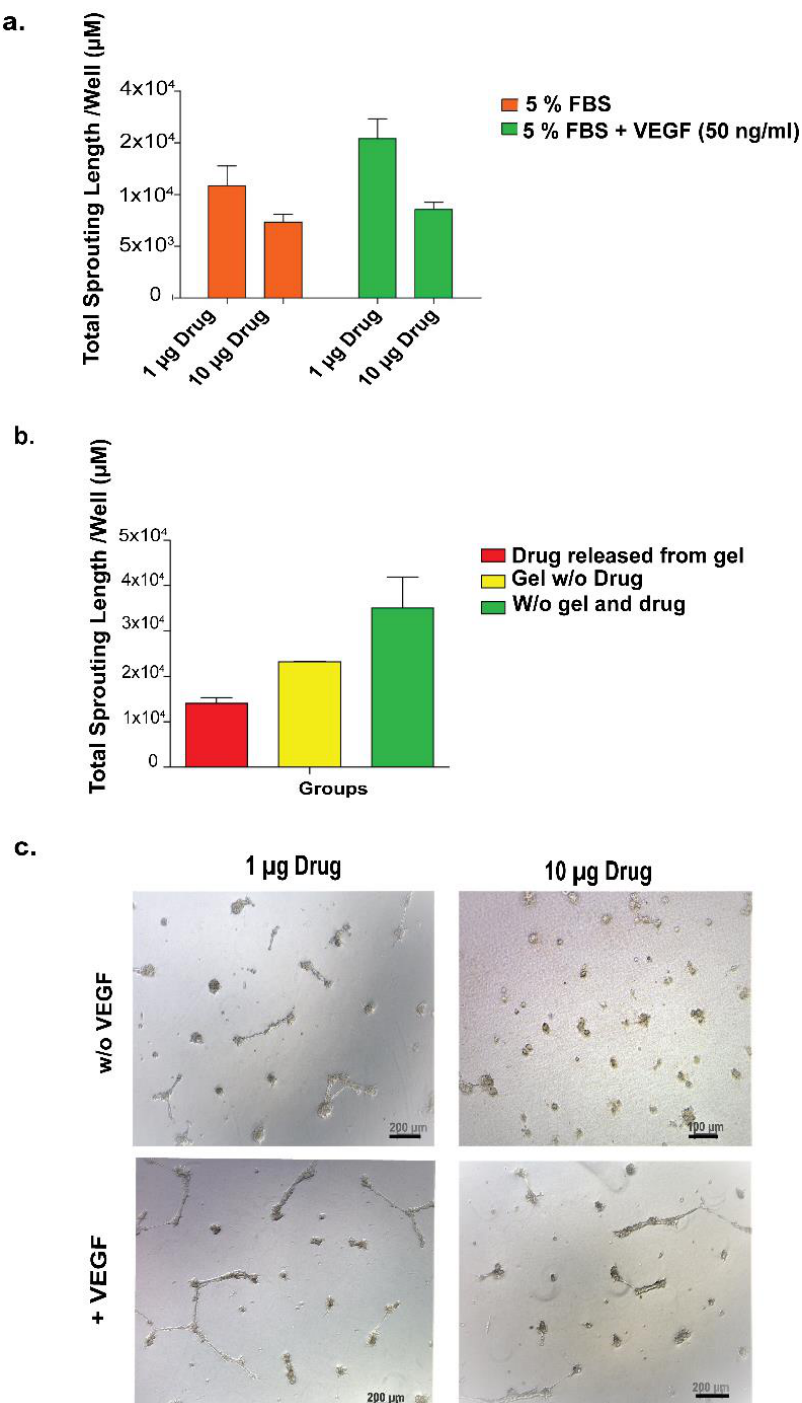
Figure 4. Anti-VEGF effect on HUVECs’ sprouting formation. ( a ) Tubular structure formation was inhibited in the presence of anti-VEGF, and this inhibition was in correlation with the drug concentration. ( b ) Light microscope images showing HUVECs on Matrigel with 1 µg or 10 µg anti-VEGF. ( c ) The number of total sprouting areas formed by HUVECs cultured on Matrigel at 48 h after they were seeded. HUVECs were exposed to drug released from the gel, gel without drug, or neither gel nor